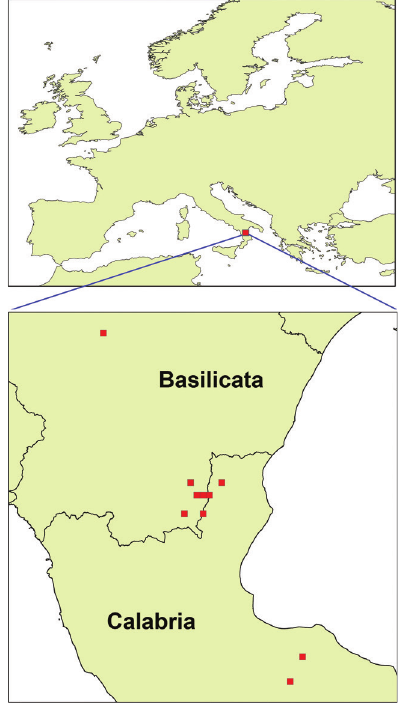
Figure 10. Geographic range and distribution map of Onosma helvetica subsp. lucana